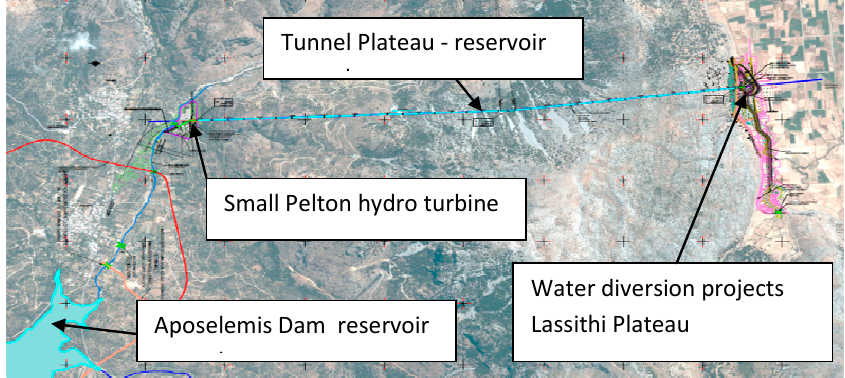
Figure 11. Panoramic view of the project.